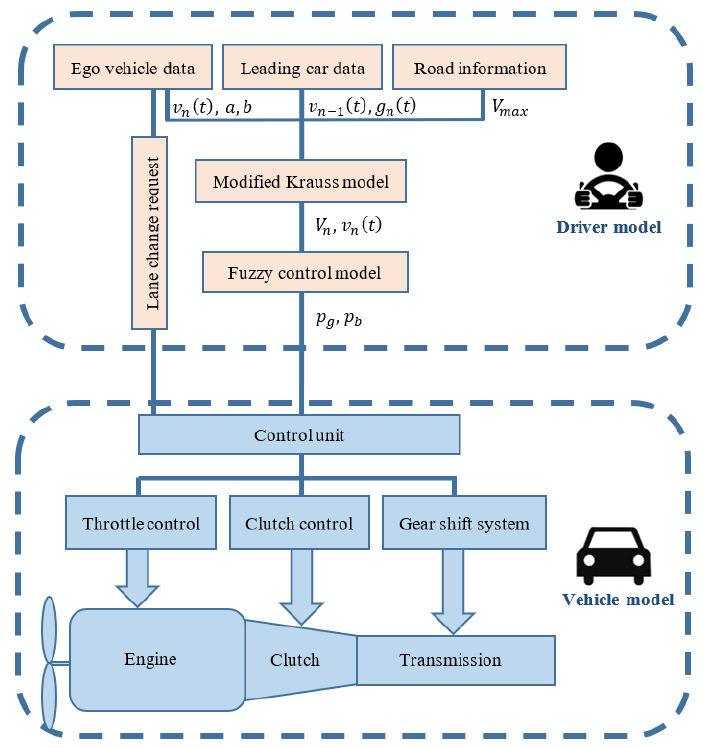
Figure 3. Driver–vehicle model in this work.